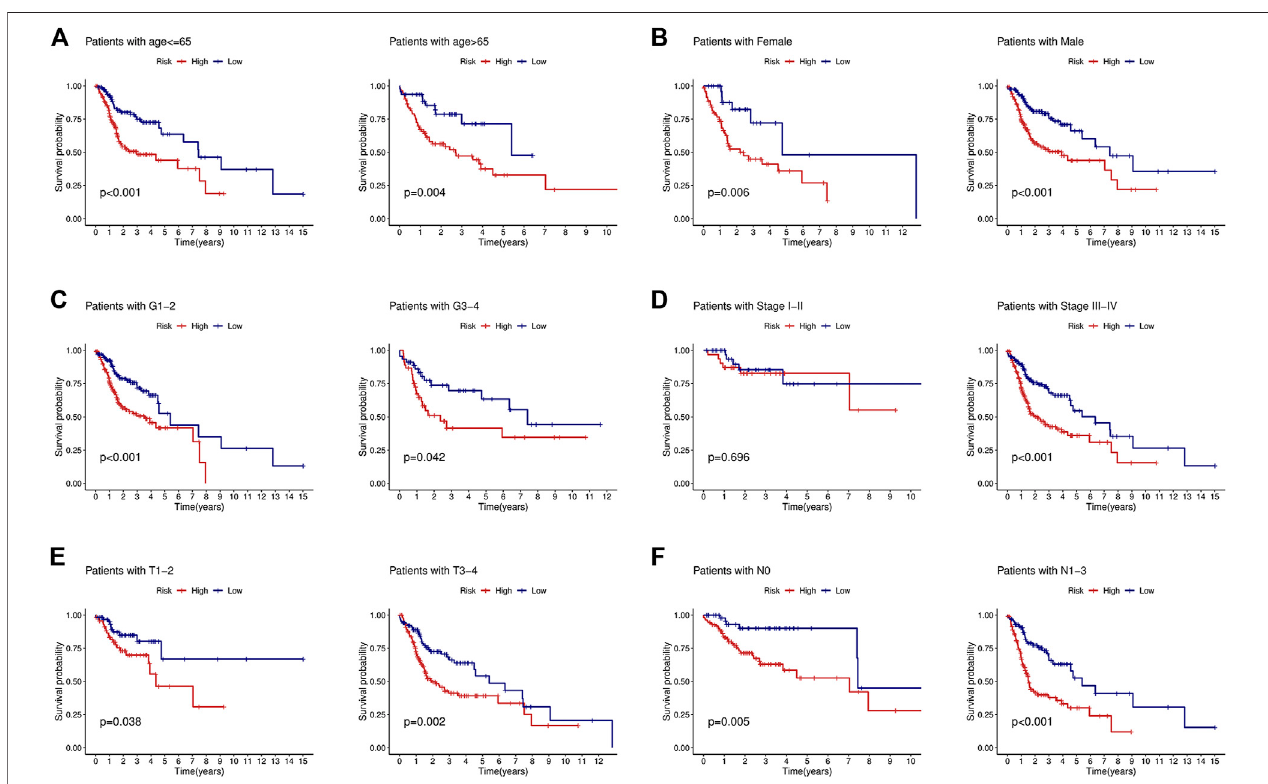
FIGURE 4 | KM curves showed that the low-risk group had a better prognosis than the high-risk group strati fi ed by the clinical features. (A) Age < =65 years and age > 65 years. (B) Female and male. (C) Grades 1 – 2 and grades 3 – 4. (D) Stages I – II and stages III – IV. (E) T1-2 and T3-4. (F) N0 and